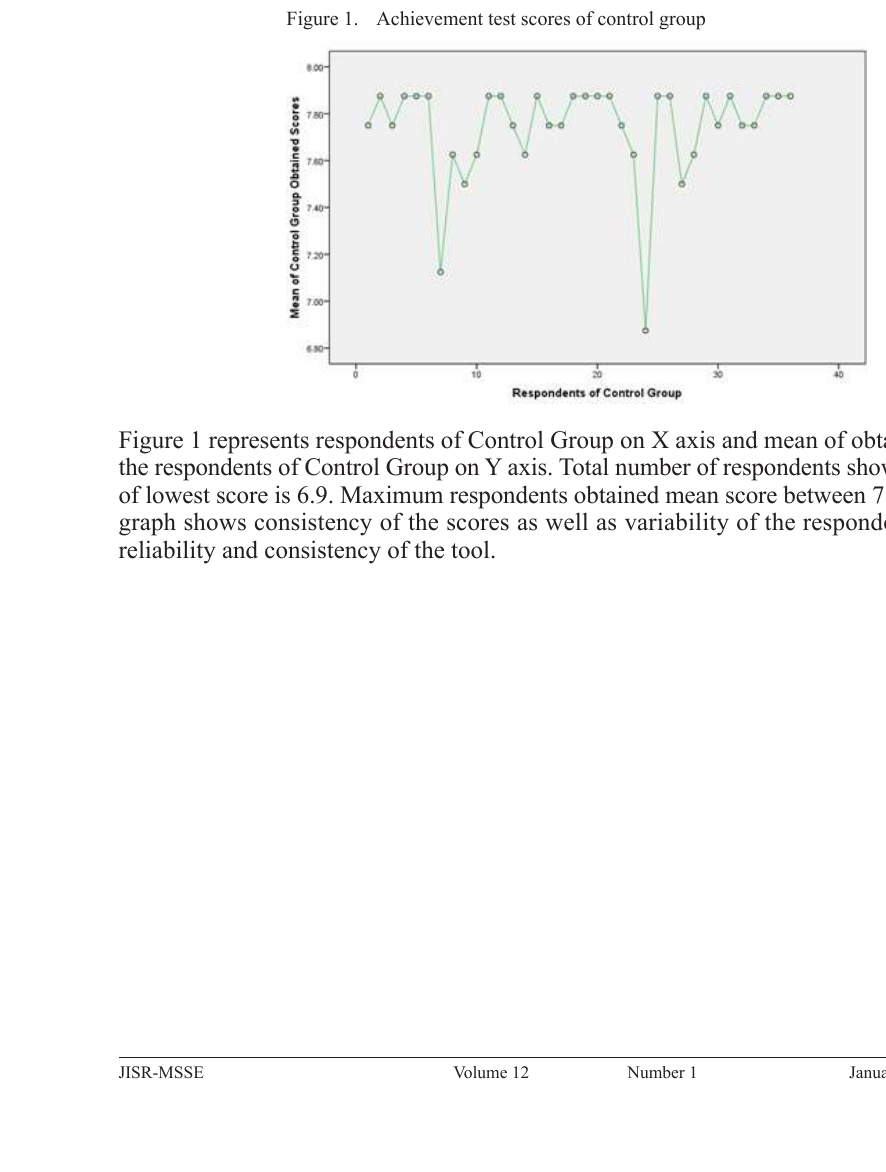
Figure 1. Achievement test scores of control